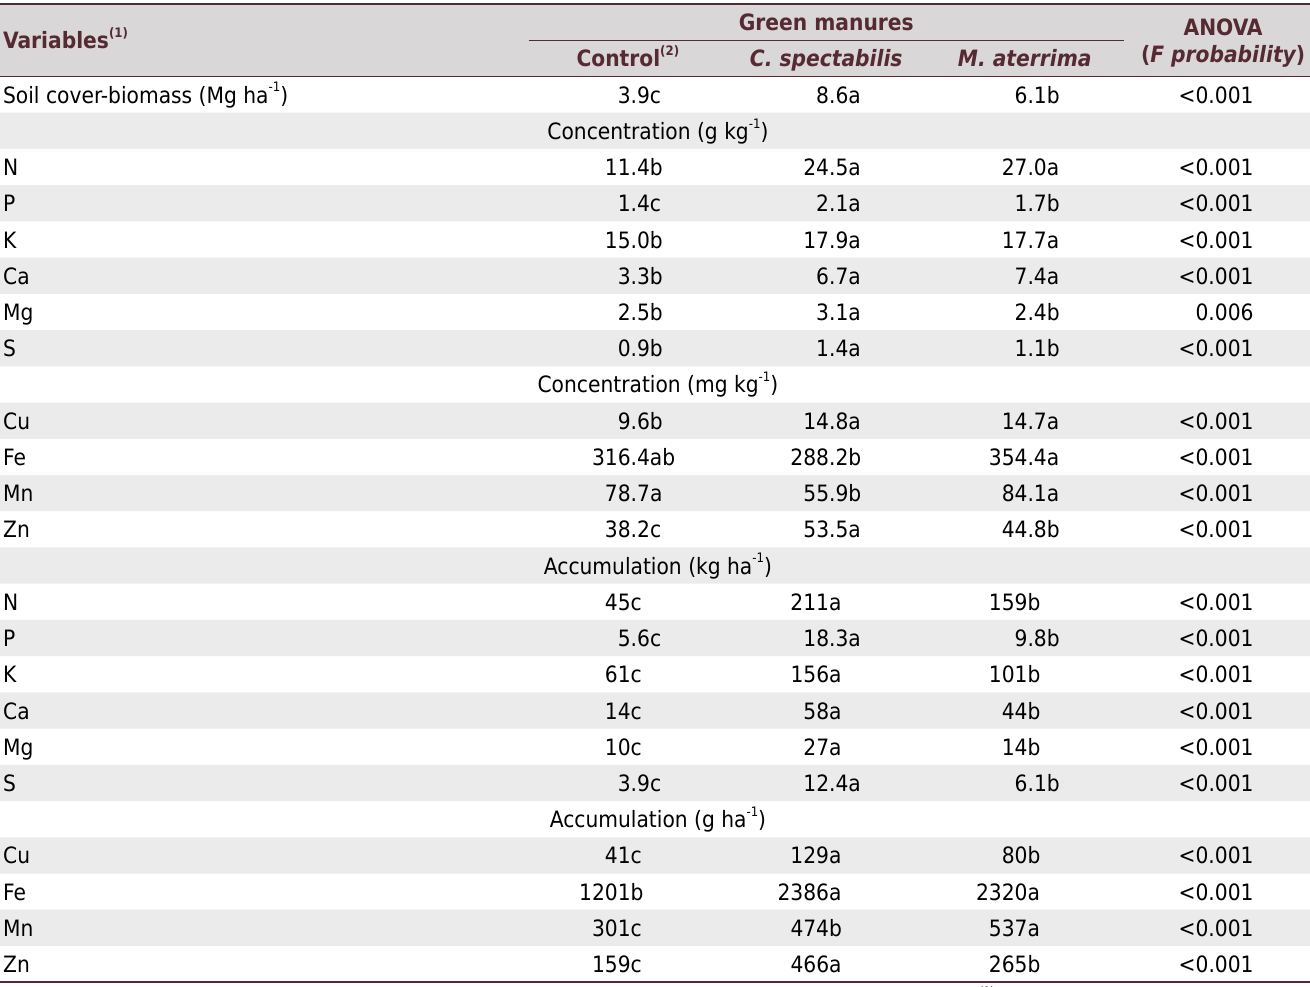
Table 2. Soil cover, nutrient concentration, and amount of nutrients in the plant residues of the green manures before soil preparation and sweet potato planting in the experimental area. Data are the means of the two agricultural years Variables (1)